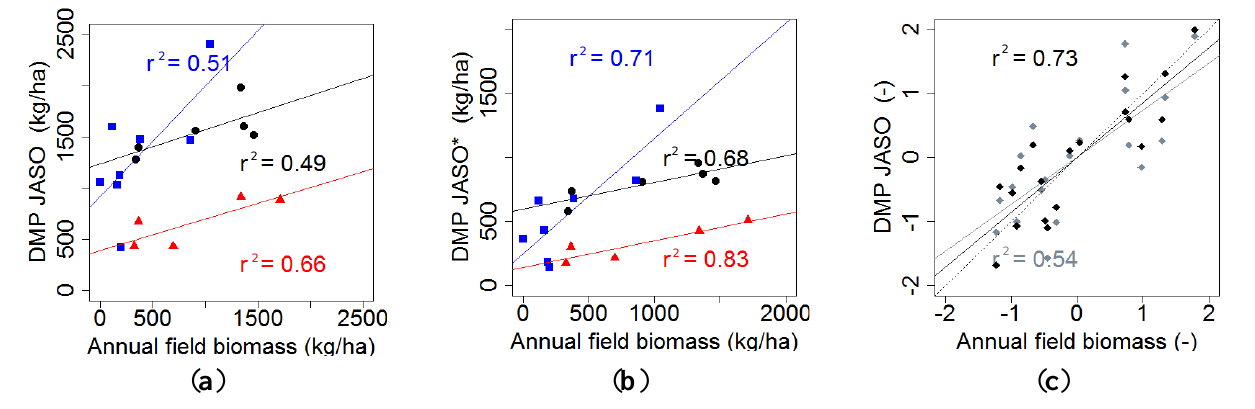
Figure 9. The correlation between annual biomass samples and satellite estimation DMP JASO (DMP, dry matter productivity) ( a ), DMP JASO * ( b ) and normalized data ( c ) ( n = 19). Black dots for Site 1, blue squares for Site 2 and red triangles for Site 3. Black and gray diamonds represent normalized DMP JASO and DMP JASO , respectively. The dotted line indicates the 1:1